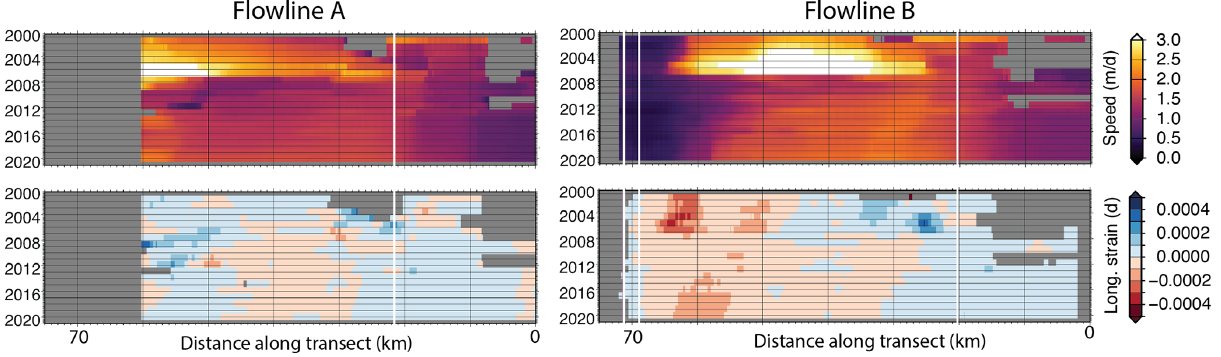
Figure 3. Hovmöller diagrams of speed and longitudinal strain rates from our long-term record along Flowlines A and B (Fig. 1). Vertical white lines represent the location of the MEaSUREs 2011 grounding line (Rignot et al.,